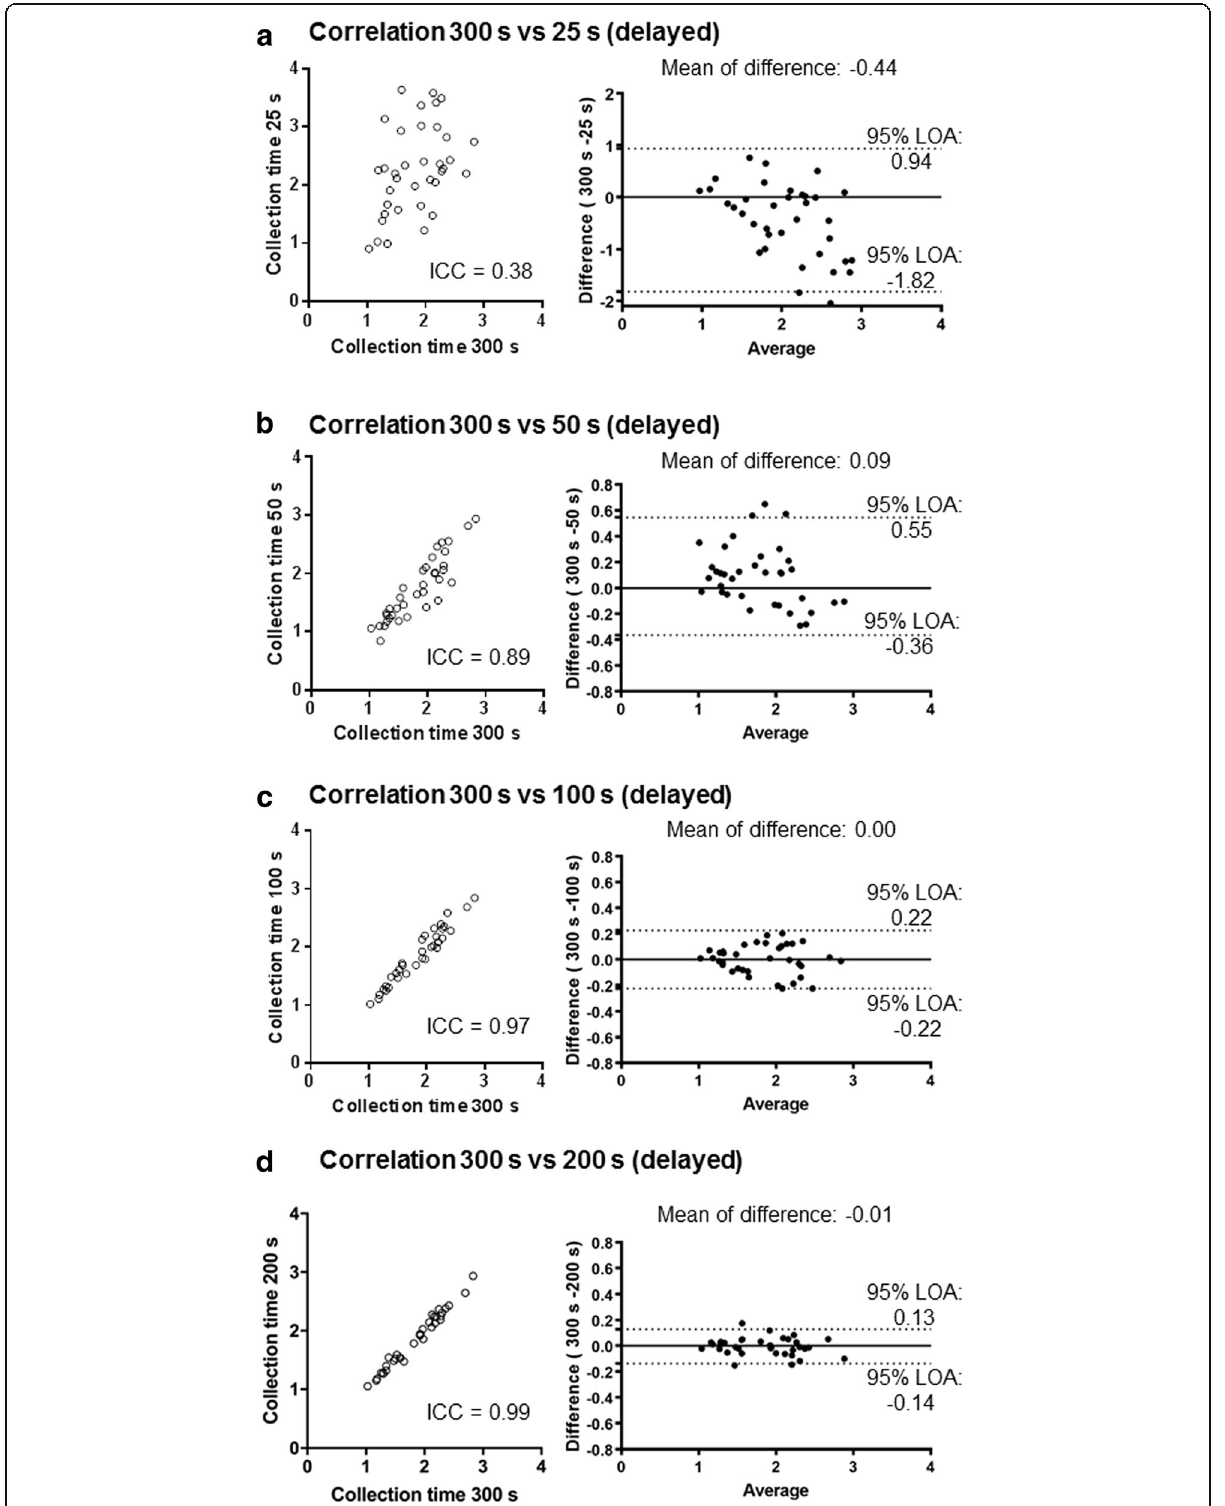
Fig. 6 a – d Concordance of delayed HMRs between different collection times (clinical study). Correlations and Bland-Altman analyses on the HMRs at the delayed phase are shown. See details in the legends of Fig.